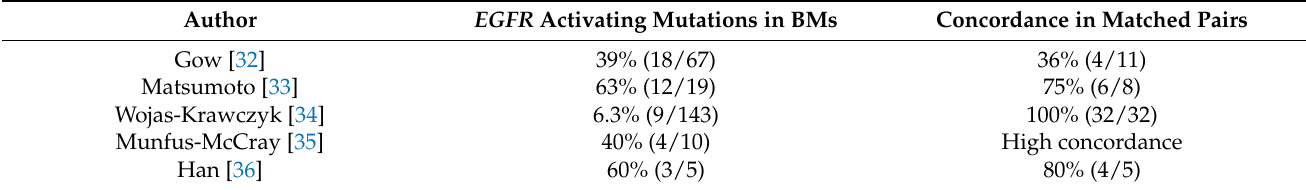
Table 1. EGFR mutations in paired primary tumors and brain